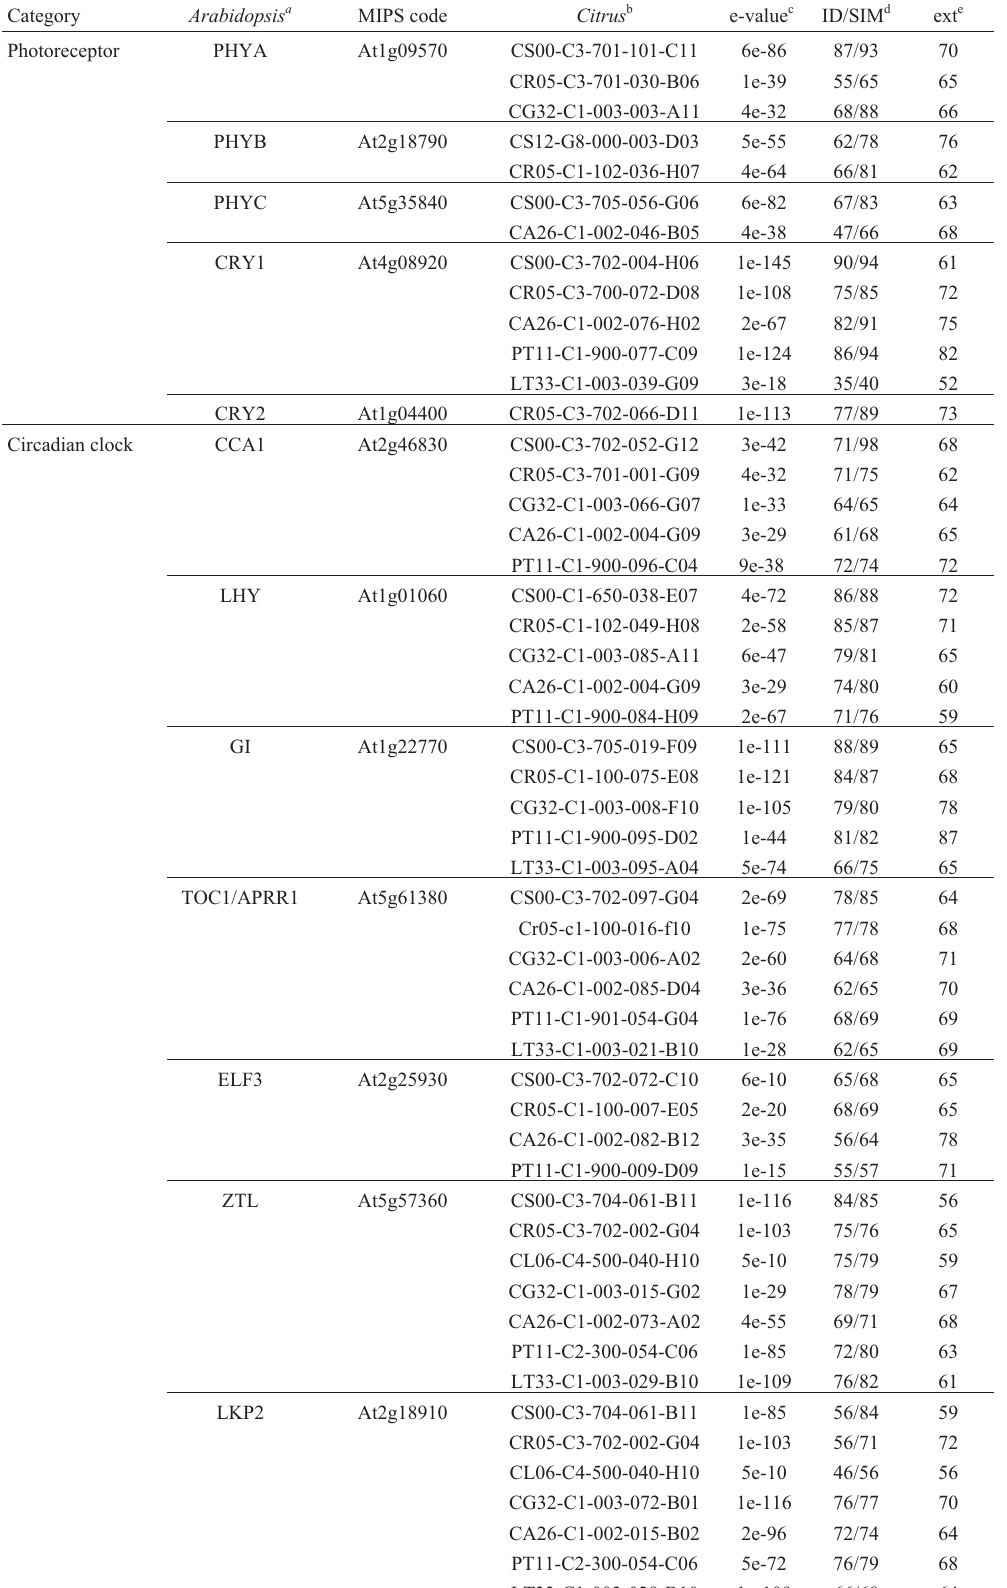
Table 1 - Citrus ESTs that share homology to flowering-time genes of Arabidopsis .